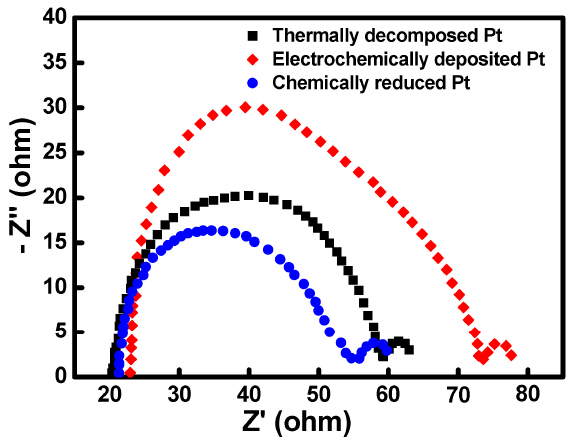
Figure 4. The EIS analytic results of simple symmetric devices (Pt-electrolyte-Pt).